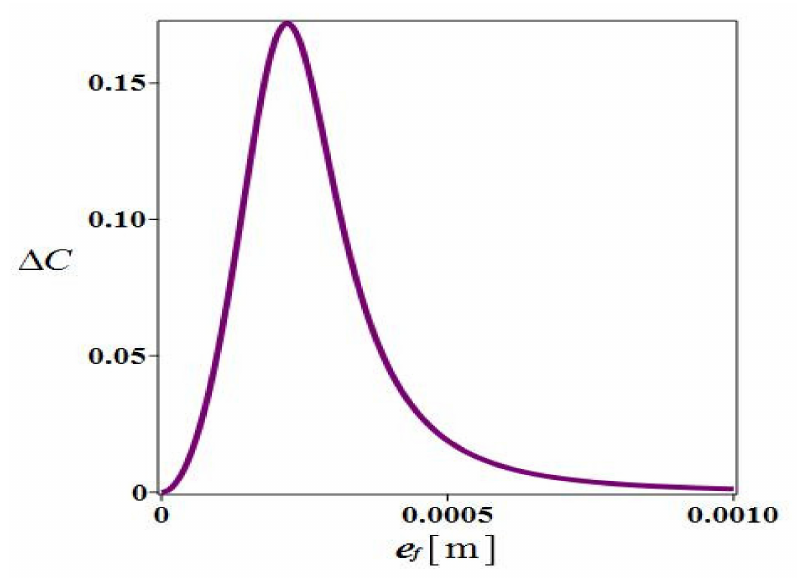
Figure 3. Variation of the species separation dependence on the thickness e f of the toluene–methanol layer of height H = 30 mm, the initial value of the mass fraction C 0 = 18.9 wt%, and ∆ T (cid:48) = 6 ◦